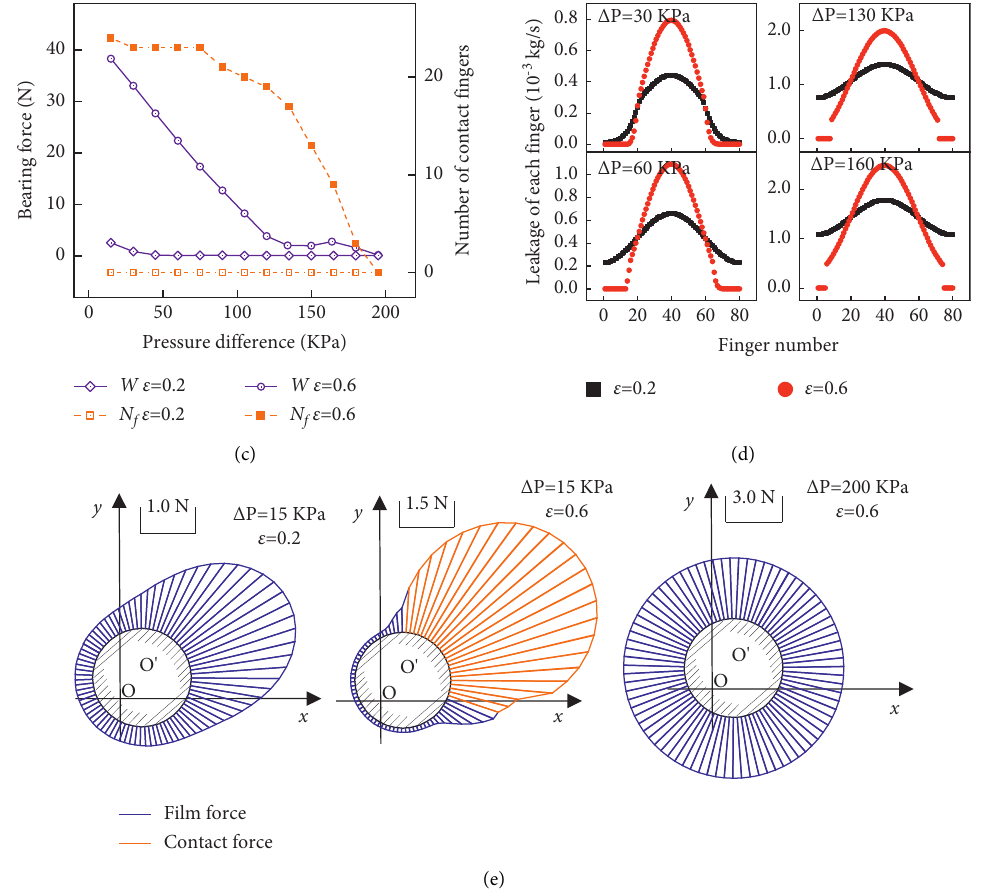
Figure 13: Effect of pressure difference. (a) Leakage for various pressure differences. (b) Friction moment for various pressure differences. (c) Bearing force for various pressure differences. (d) Leakage of each finger. (e) Force acting on the rotor by each finger.